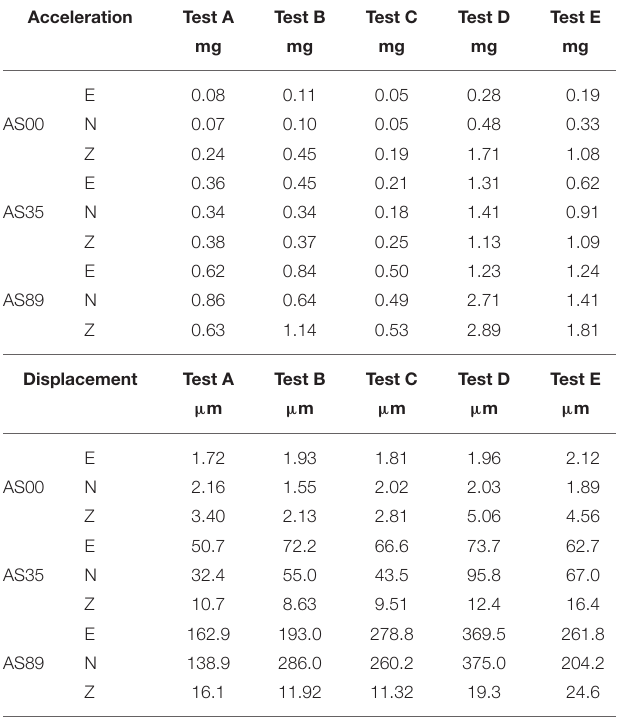
TABLE 5 | Acceleration and displacement peak values recorded during the